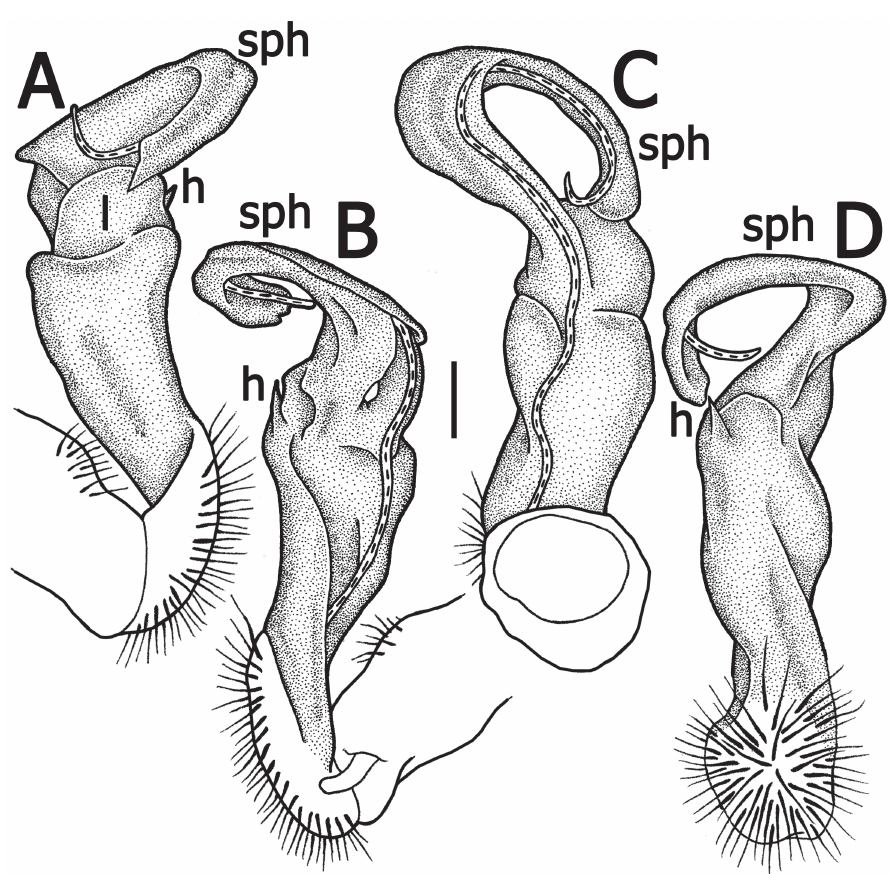
Fig. 22. Tylopus punctus sp. nov., holotype, ♂. A–D . Left gonopod, lateral, mesal, subcaudal and suboral views, respectively. Scale bar = 0.2 mm. abbreviations are explained in